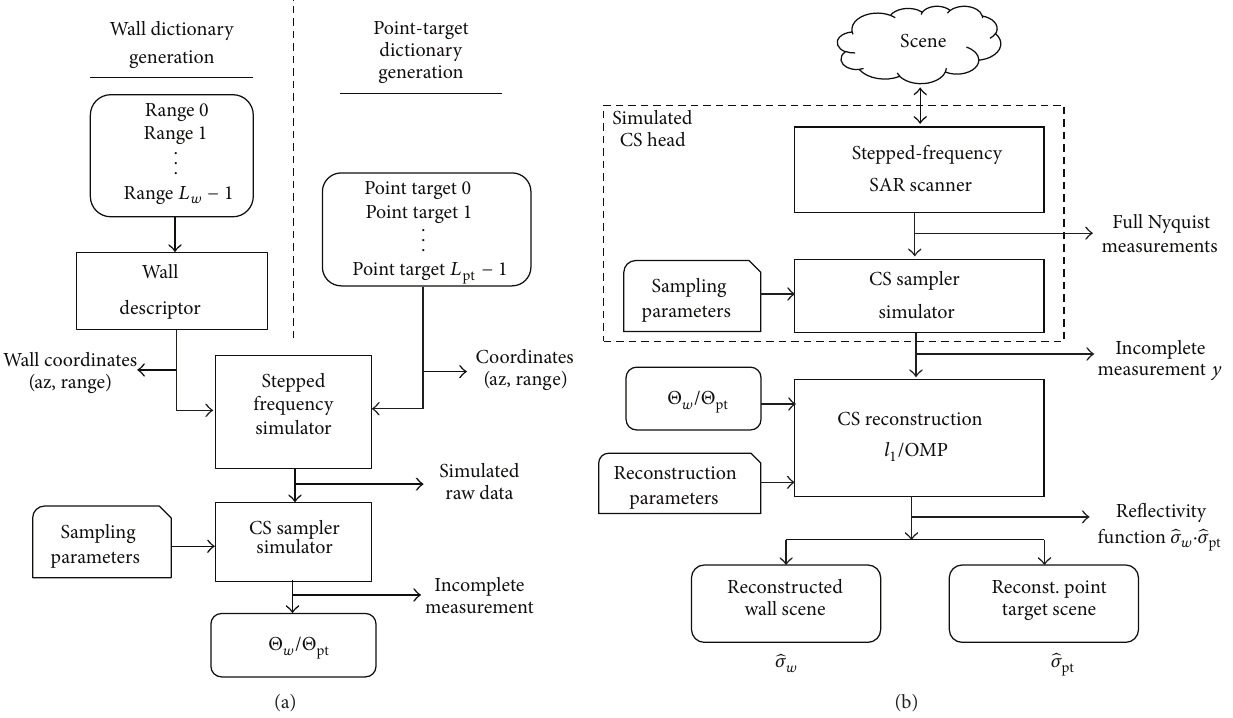
Figure 12: Block diagrams of the (a) wall and point-target dictionary generation and (b) scene reconstruction from actual incomplete